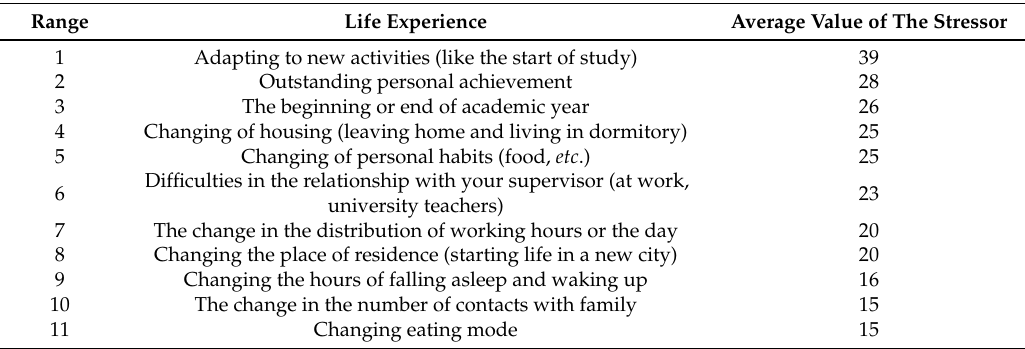
Table 1. The list of life events as